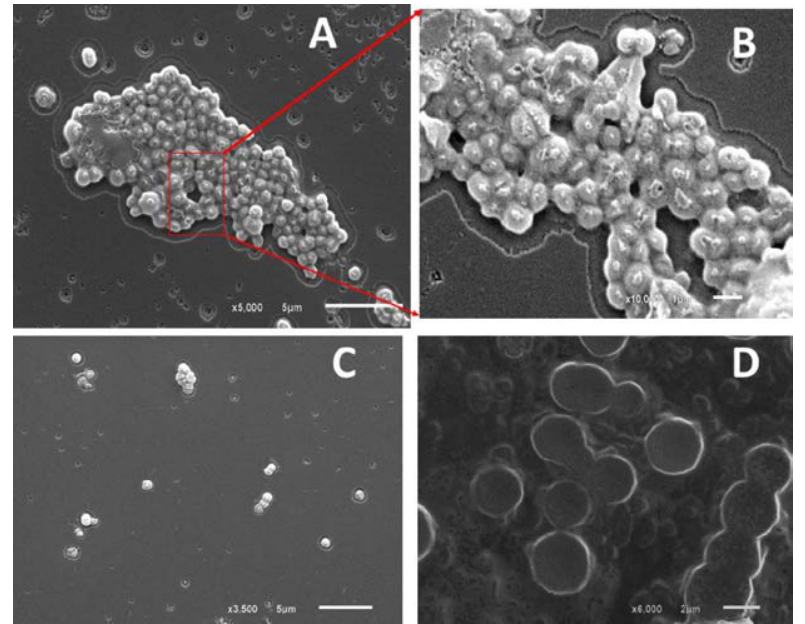
Fig. 3. Biofilm formation in Staphylococcus haemolyticus (a) Planktonic cell (b) enlargement of red box view of planktonic cell (c) in presence of Pluronic F127 (d) in presence of